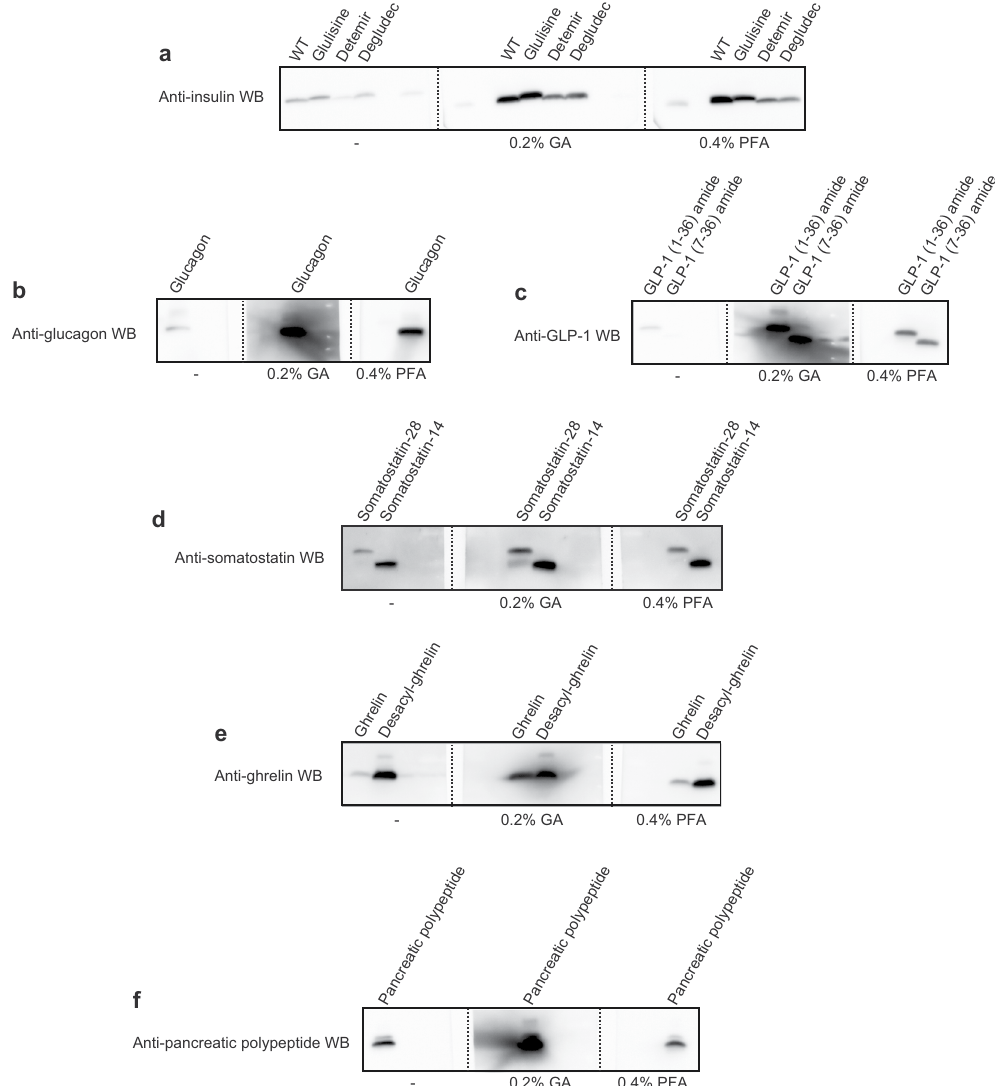
Figure 6. Application for insulin analogs and other peptide hormones involved in diabetes. Reference standard (100 ng) of each peptide was subjected to the improved WB using 0.2% GA or 0.4% PFA as the step of aldehyde treatment or general WB for control. ( a ) Insulin analogs (insulin [wild type], insulin glulisine, insulin detemir, and insulin degludec), ( b ) glucagon, ( c ) GLP-1s (GLP-1 (1-36) amide and GLP-1 (7-36) amide), ( d ) somatostatins (somatostatin-28 and somatostatin-14), ( e ) ghrelins (ghrelin and desacyl ghrelin), and ( f ) pancreatic polypeptide. To compare the effects of various conditions, WB images in each sub-part of the figure were captured at one